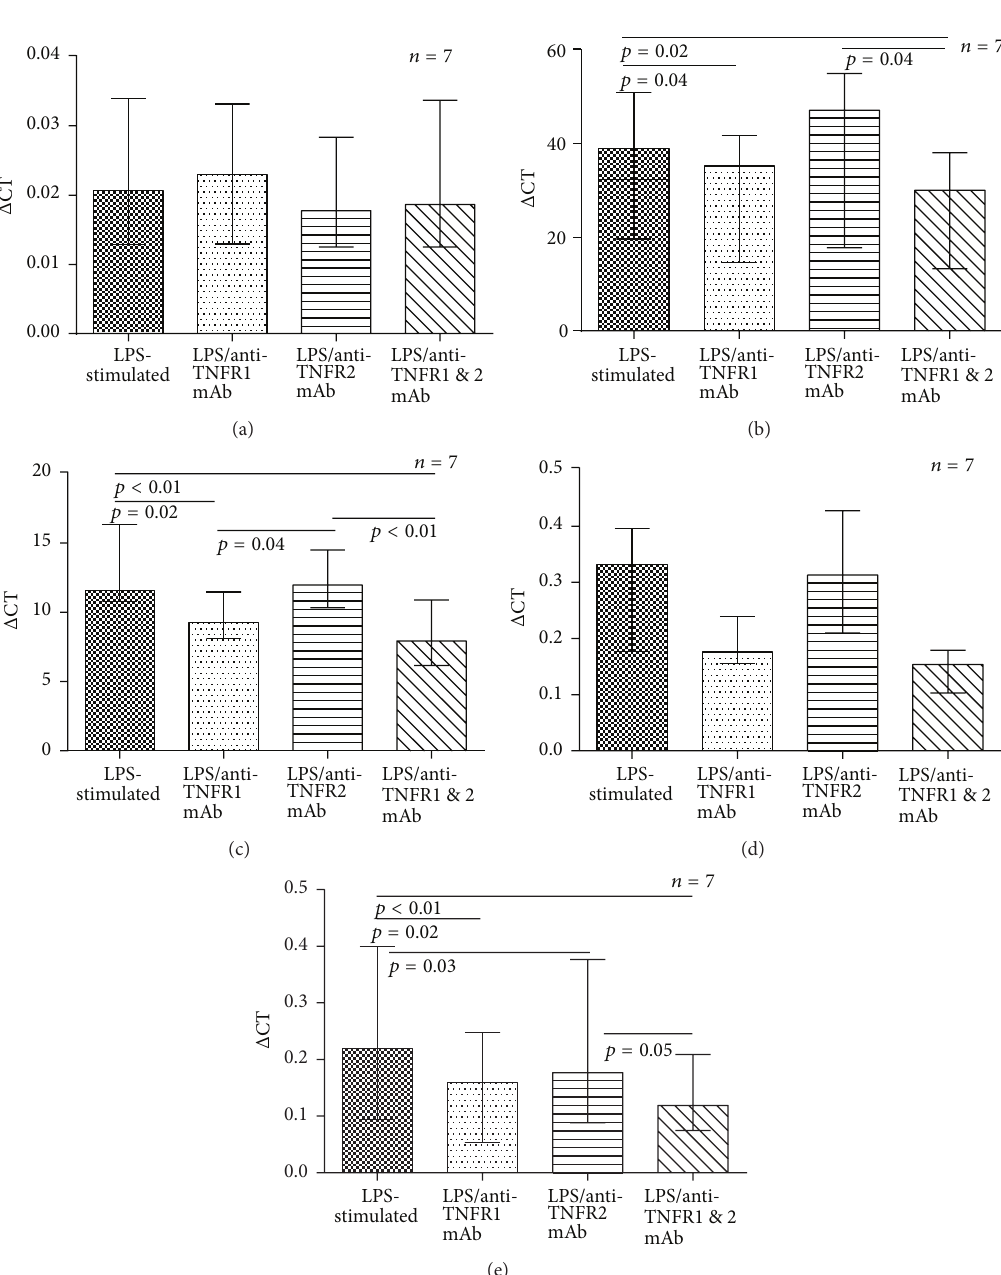
Figure 2: Effect of selective TNF- 𝛼 receptor blockade on cytokine mRNA expression. Monocytes were stimulated with 100ng/mL of LPS (positive control) for 20 hours ± TNFR1/TNFR2 mAb/both (10 𝜇 g/mL), and cytokine mRNA expression was measured. Each column shows median (IQR) values. Overall differences between experimental conditions for each cytokine were assessed with Friedman’s test and post (b) CXCL8: Friedman’s test 𝑝 = 0.03 . (c) IL-1 𝛽 : Friedman’s test 𝑝 < 0.01 . (d) IL-6: no overall difference observed. (e) IL-10: Friedman’s test 𝑝 <